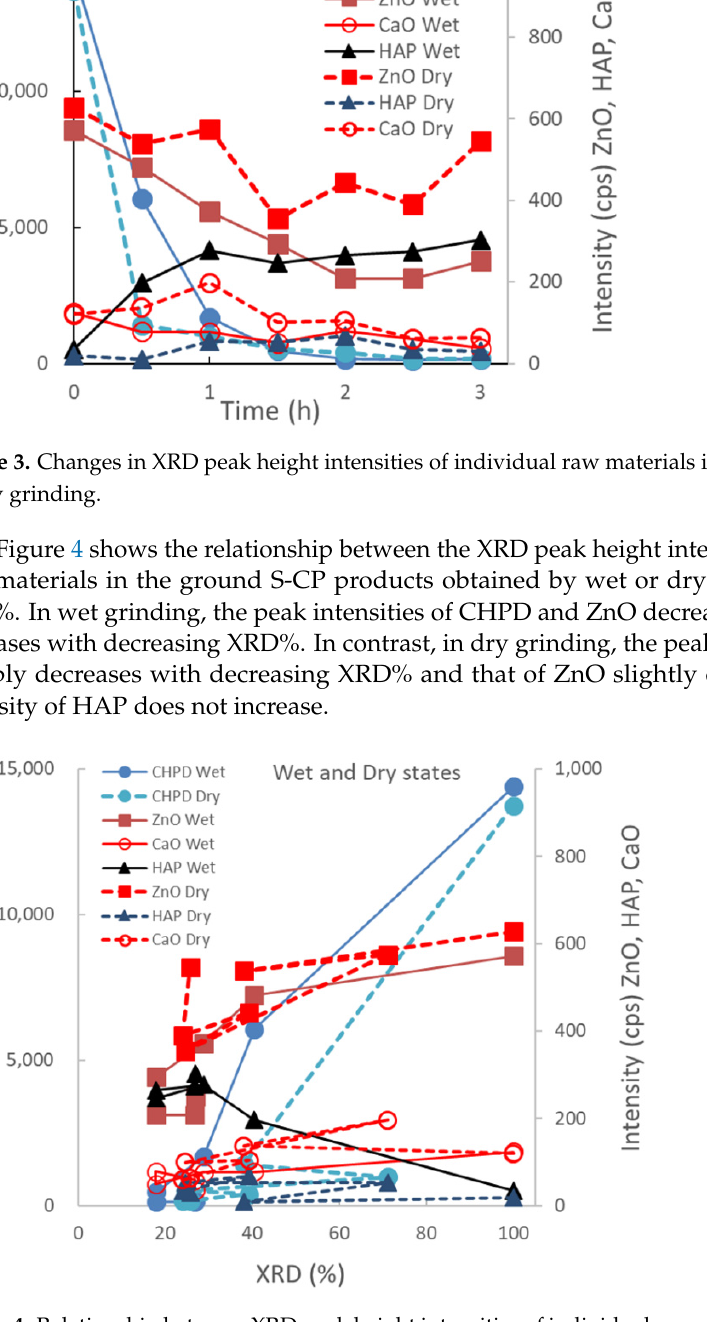
Figure 4. Relationship between XRD peak height intensities of individual raw materials in the ground S-CP products obtained by wet or dry grinding and their